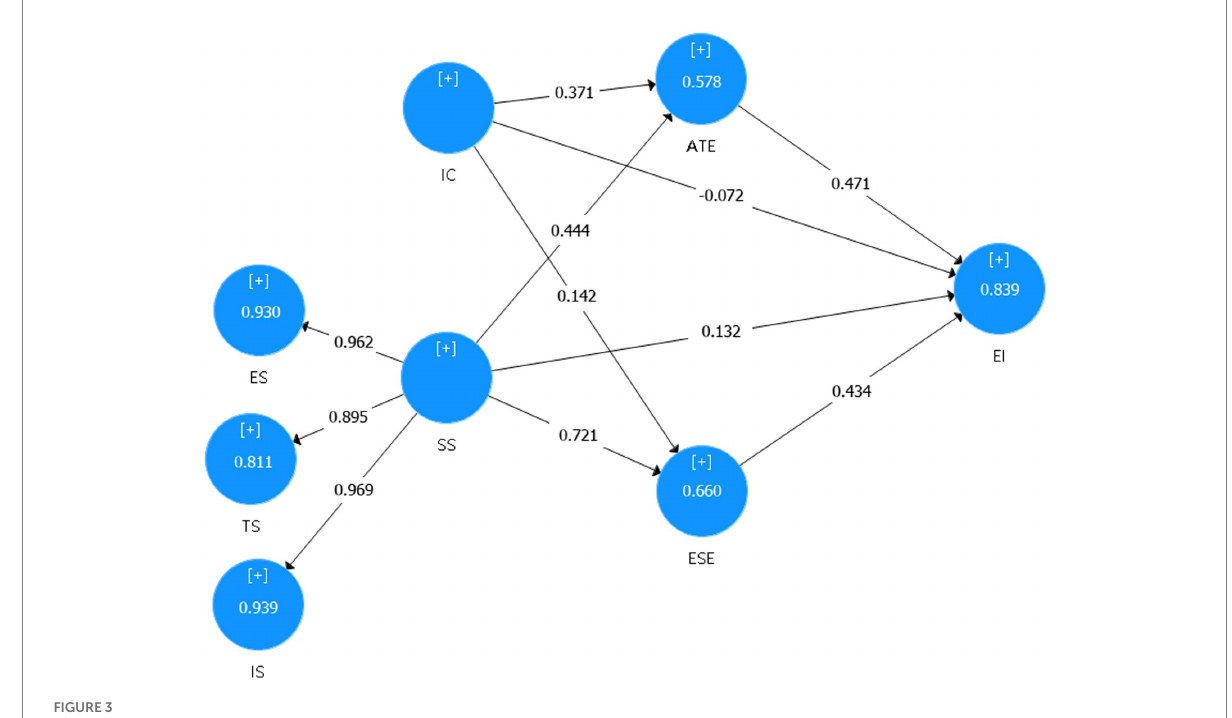
FIGURE 3 PLS results of the research